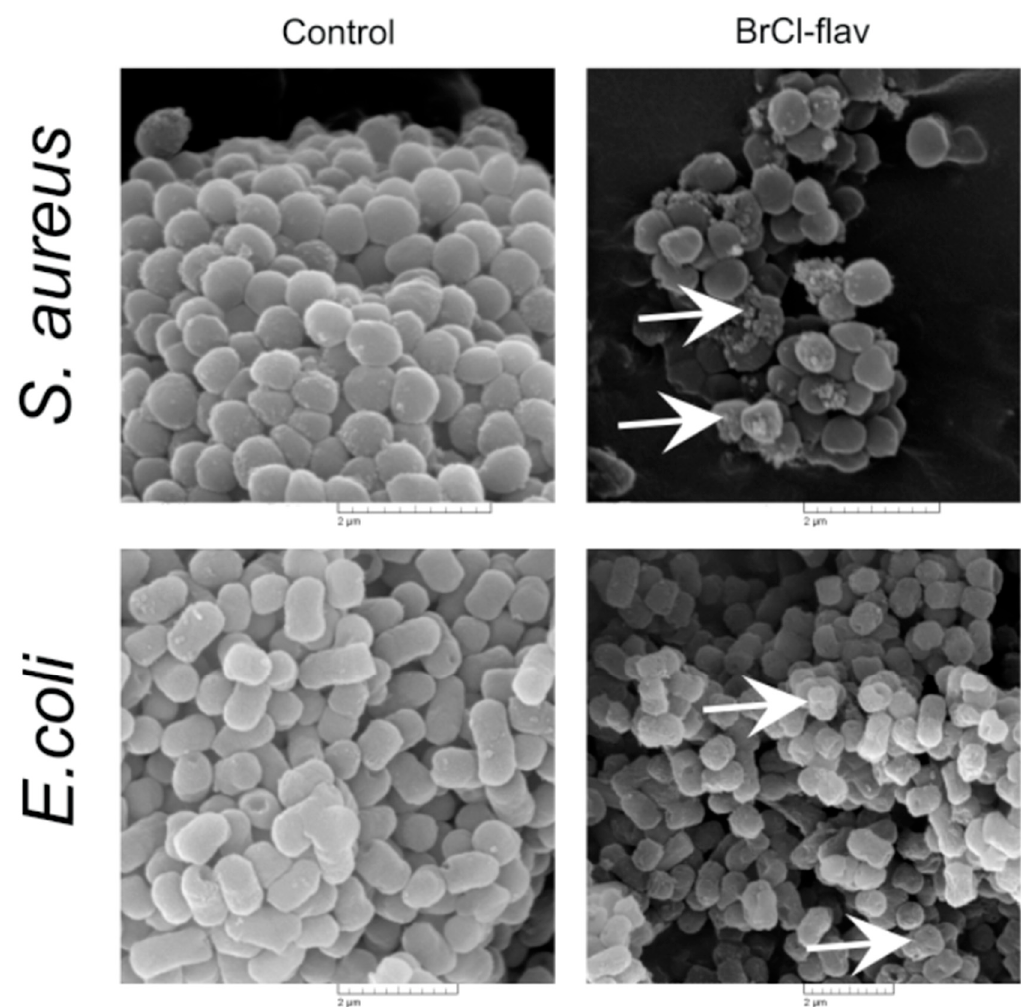
Figure 7. The effects of BrCl-flav on the morphology of S. aureus medbio1-2012 and E. coli medbio4- 2013. Control cells with normal morphology. Cells exposed for 6 h to concentrations equivalent to MBC. White arrows indicate morphological damages and cellular debris.